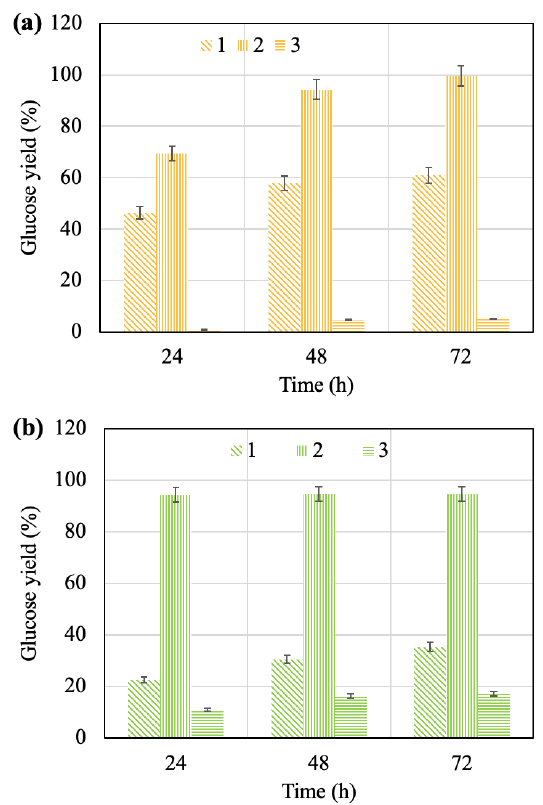
Figure 3. Effect of time on glucose yield during enzymatic hydrolysis of pretreated apricot seed shells ( a ) and walnut shells ( b ): 1—after acid pretreatment; 2—after alkaline pretreatment; 3—after steam explosion pretreatment.